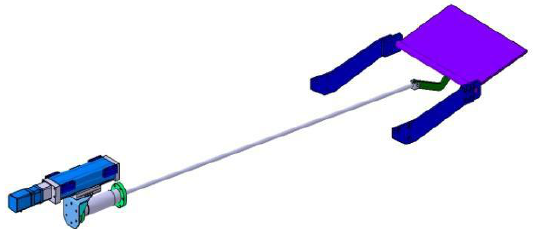
Fig.10. Schematic drawing of the